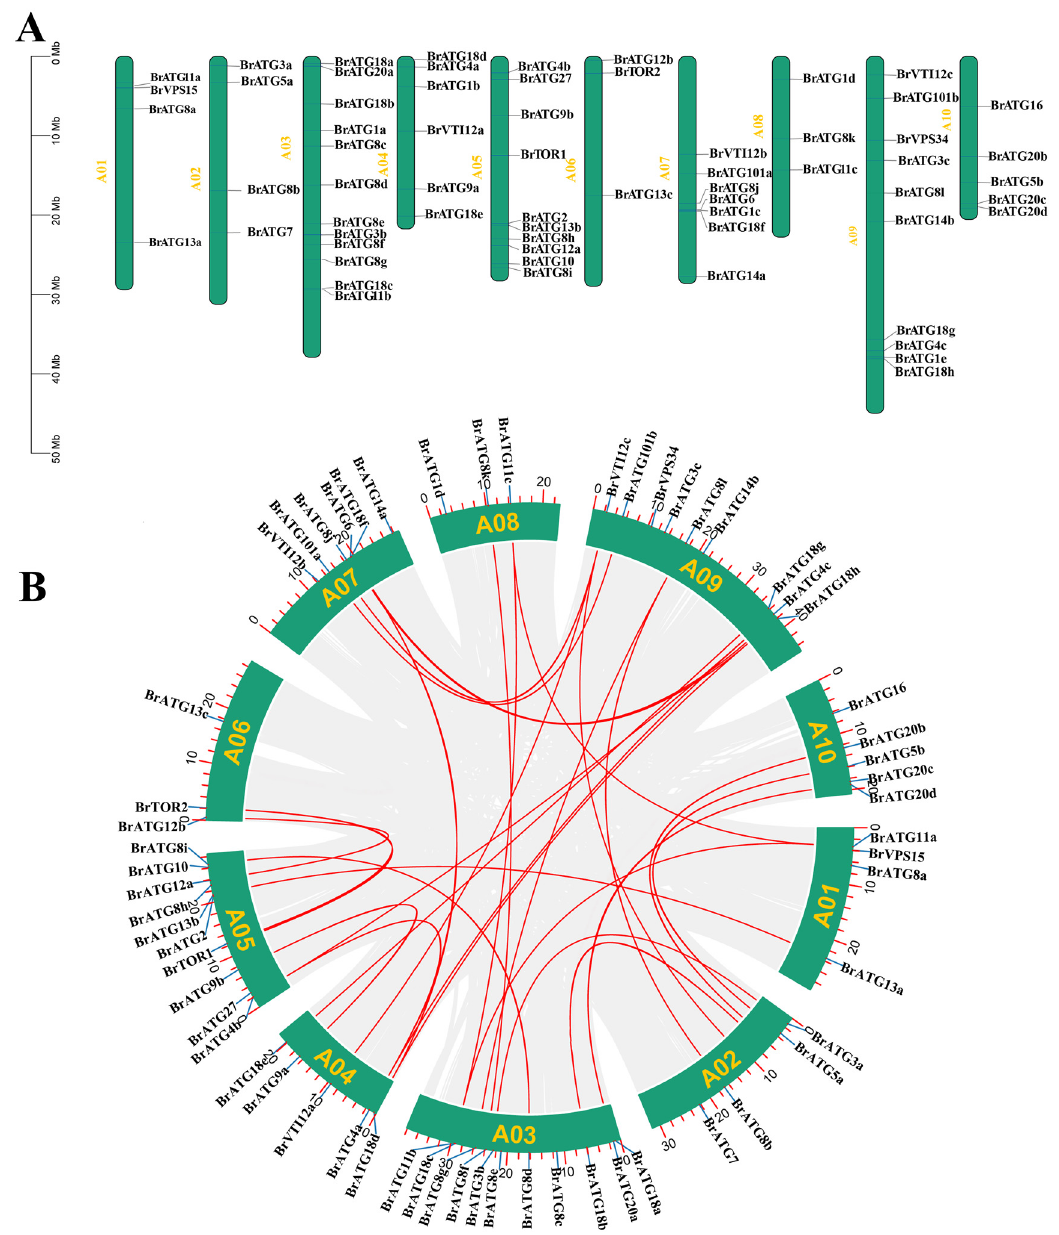
Figure 5. Chromosome distribution ( A ) and schematic representation of interchromosomal relationships ( B ) of the BrATG gene in Chinese cabbage. Repeated BrATG gene pairs are highlighted with red lines.